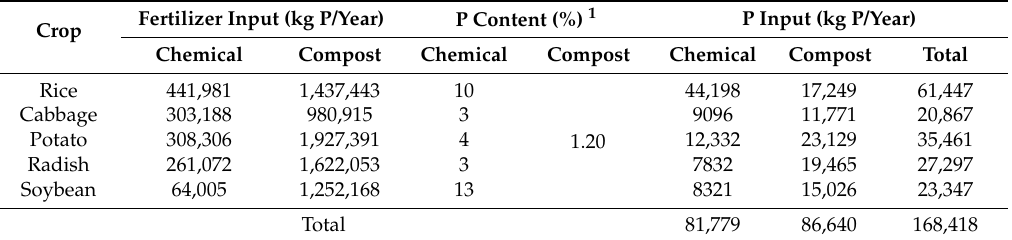
Table 4. P inputs from fertilizer (chemical and compost) for the five most common crops in the Haean watershed.